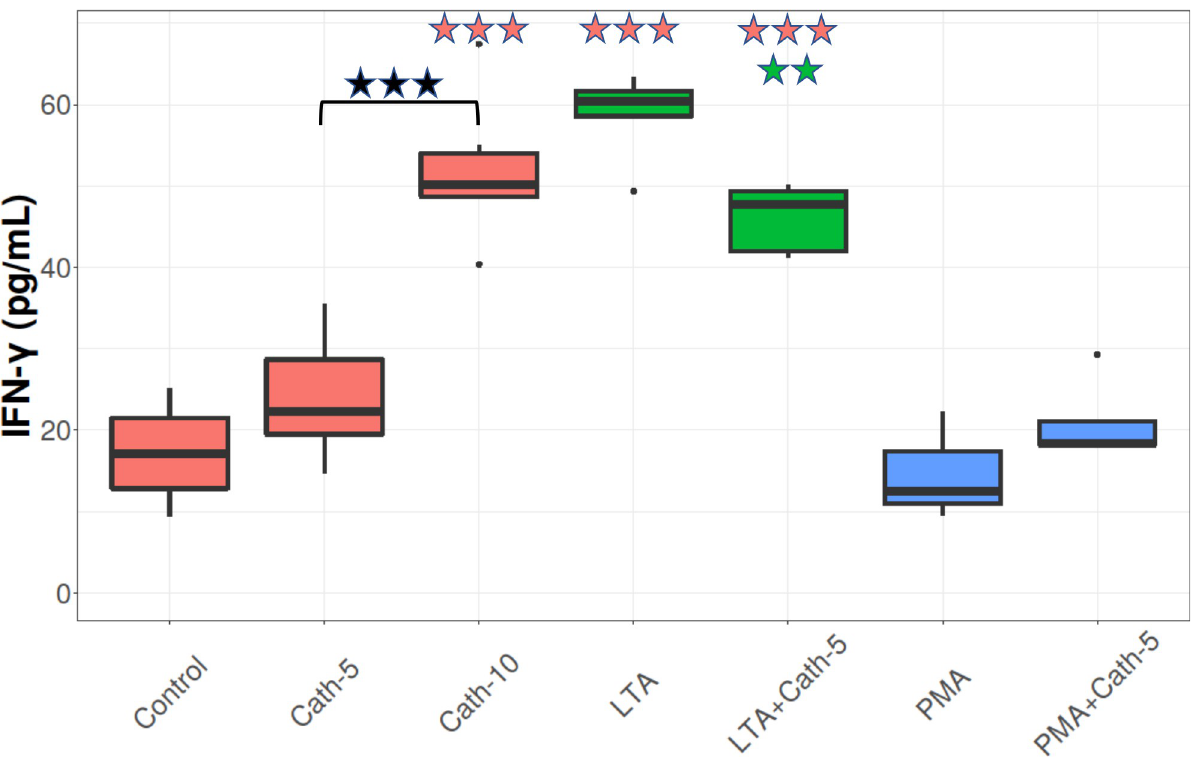
Fig 3. IFN- γ concentration. Boxplots showing the interferon- γ (IFN- γ ) concentration for hepatocyte—non-parenchymal cell co-cultures treated with chicken cathelicidin-2 (Cath), lipoteichoic acid (LTA), or phorbol myristate acetate (PMA) only, or the combination of Cath and LTA or PMA (n = 6/ group). Results are displayed as pg/mL. Cath-5 = 5 nmol/mL Cath, Cath-10 = 10 nmol/mL Cath, LTA = 50 μ g/mL Staphylococcus aureus LTA, PMA = 1000 ng/mL PMA. The Control refers to absolute control cells that received none of the treatments. Red asterisks over the boxes refer to significant differences compared to control cells, green asterisks to the group treated only with LTA, blue asterisks to the group treated only with PMA, and black asterisks between the two concentrations of Cath. �� p < 0.01, ��� p < 0.001.